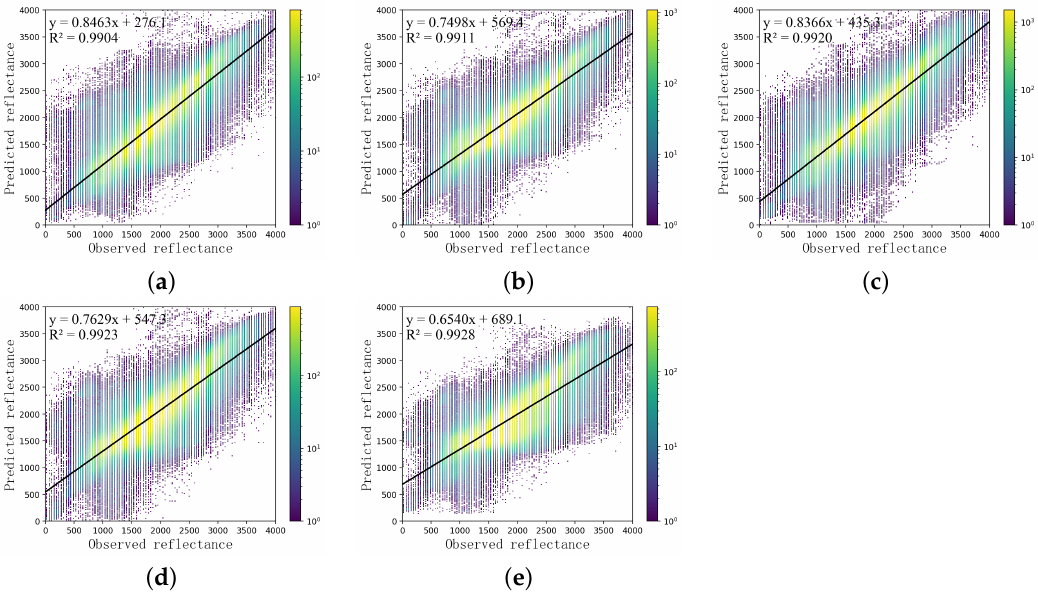
Figure 6. Correlation between the NIR band predicted image and real image on 4 May 2002 of CIA.